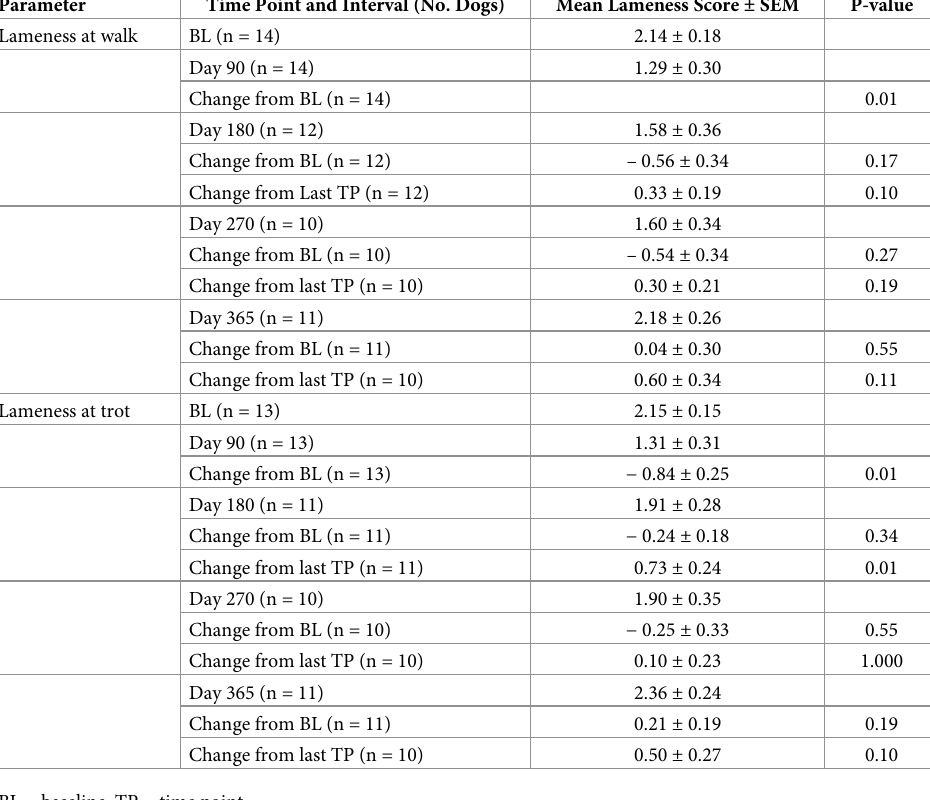
Table 3. Clinician assessment of lameness score at walk or trot following treatment with 117-tin colloid. Parameter Time Point and Interval (No. Dogs) Mean Lameness Score ± SEM P-value Lameness at